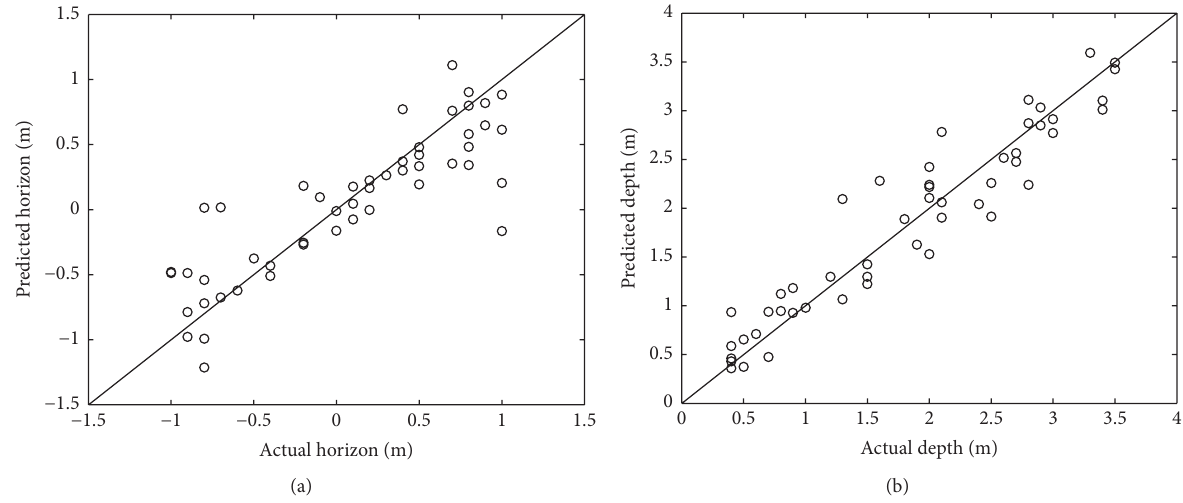
Figure 6: Predicted values of (a) horizon and (b) depth of the target center versus the actual